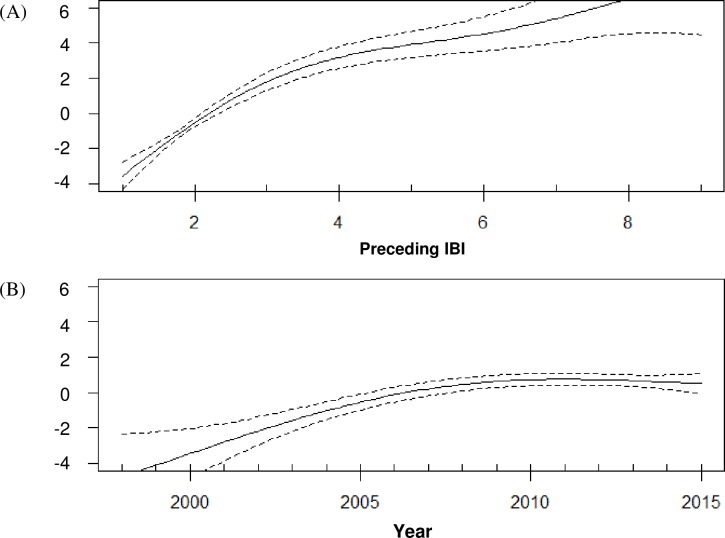
GAMM results showing smoothers for effects of: (A) time since previous birth in years and (B) the calendar year, on the likelihood of calf births. The strength and direction of the effect is shown by the y-axis. The dotted lines correspond to 95% confidence intervals.